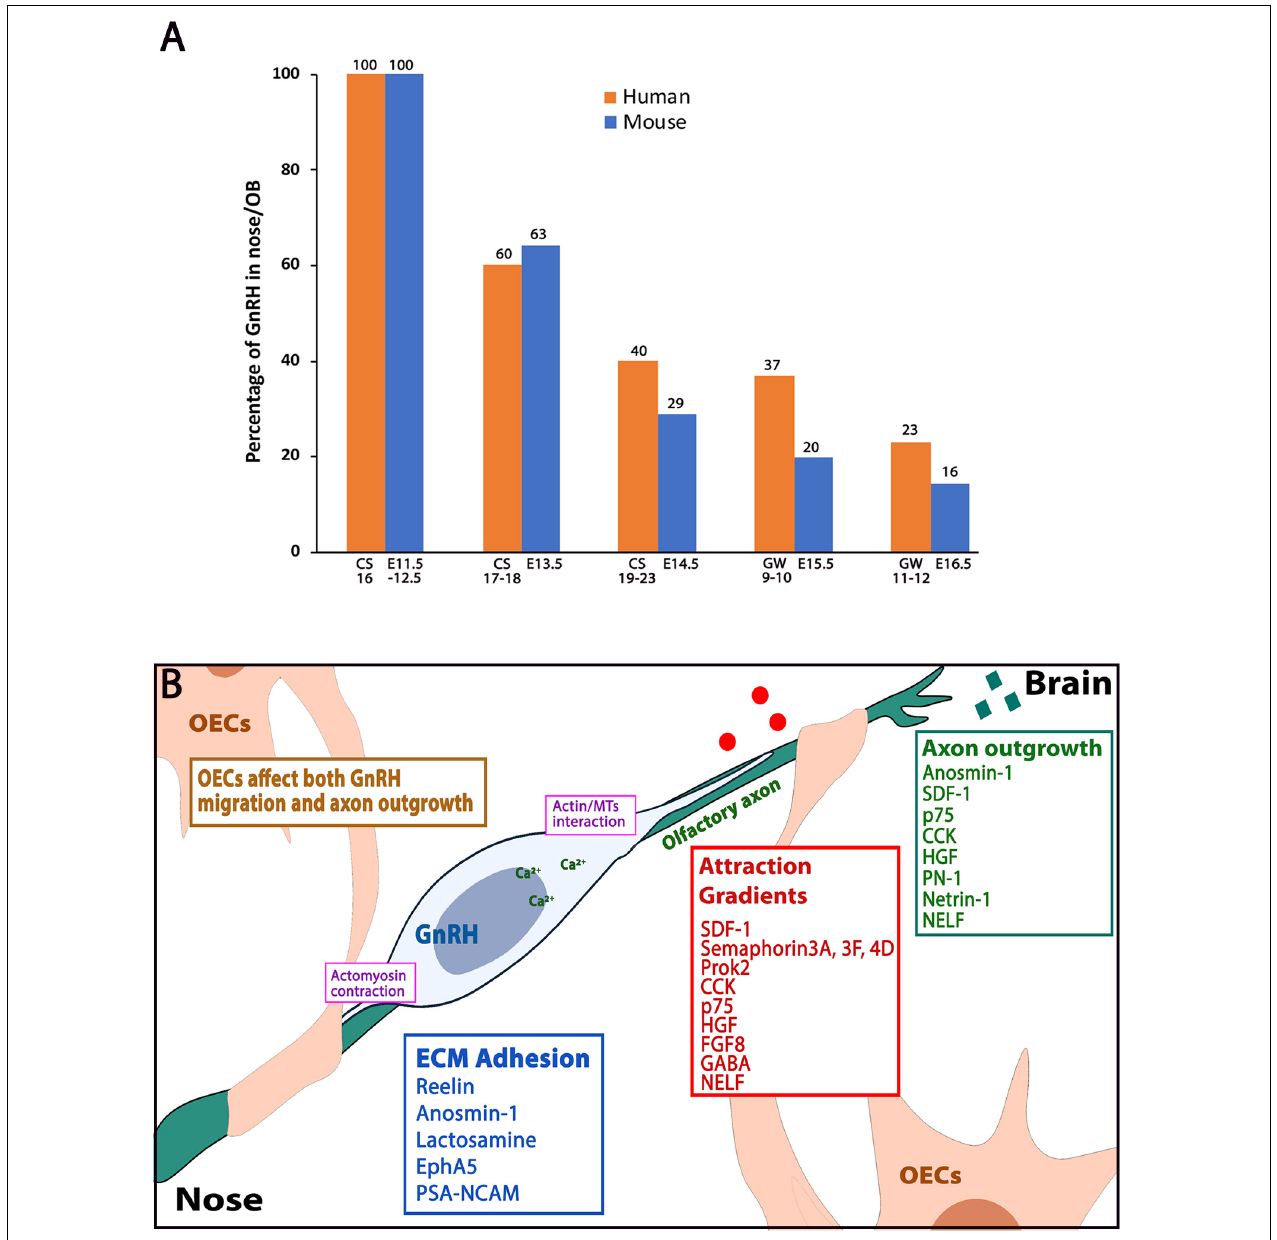
FIGURE 4 | Human-mouse GnRH distribution plot and molecules affecting GnRH neuronal migration. (A) Plot showing percentage of GnRH neurons that reside in nose/OB area between human (orange bars) and mouse (blue bars) at five developmental windows. CS: carnegie stage, GW: gestation week, E: embryonic stage. Data adapted from Casoni et al. (2016) and Wray et al. (1989b). (B) Schematic showing a GnRH neuron (blue) along the olfactory axon bundles (green), which are ensheathed by OECs (beige). Categories of axon outgrowth cues (green box), migration attraction gradients cues (red box) and ECM adhesion molecules (blue box) are indicated. Actin/microtubule interactions and actomyosin contractions (pink boxes) occur at the leading process and the trailing process of the migrating GnRH